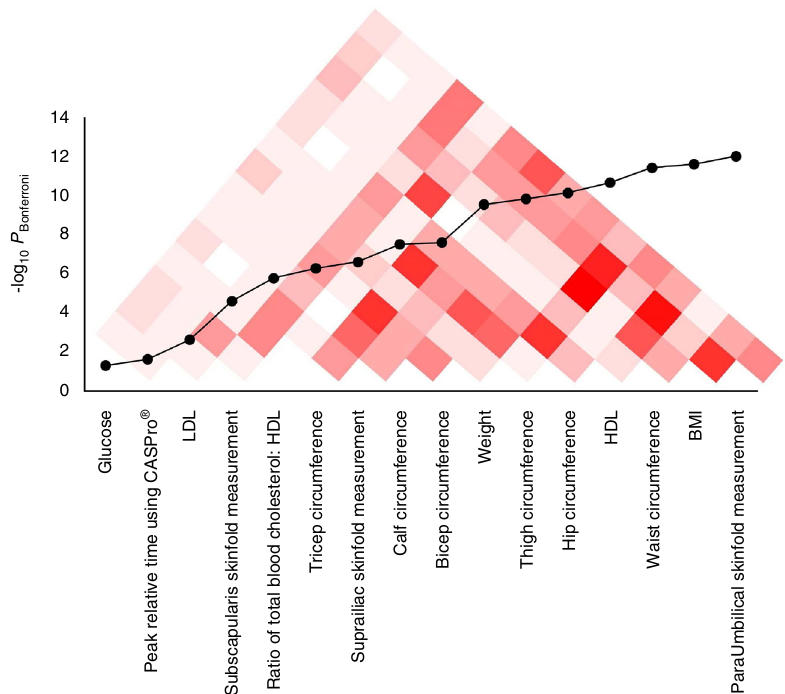
Fig. 5 Distribution of the differences and correlation of the 16 signi fi cant differentiated clinical phenotypes across three populations. The distribution of the differences of the 16 clinical signi fi cant phenotypes across three populations, with a correlation heatmap of the phenotypes. The correlation was calculated using Pearson ’ s correlation, r ² , across 358 samples. The intensity of the color re fl ects the magnitude of the correlation, in which the white color means r ² = 0 and red color means r ² = 1. The details of the differences can be found in Supplementary Table